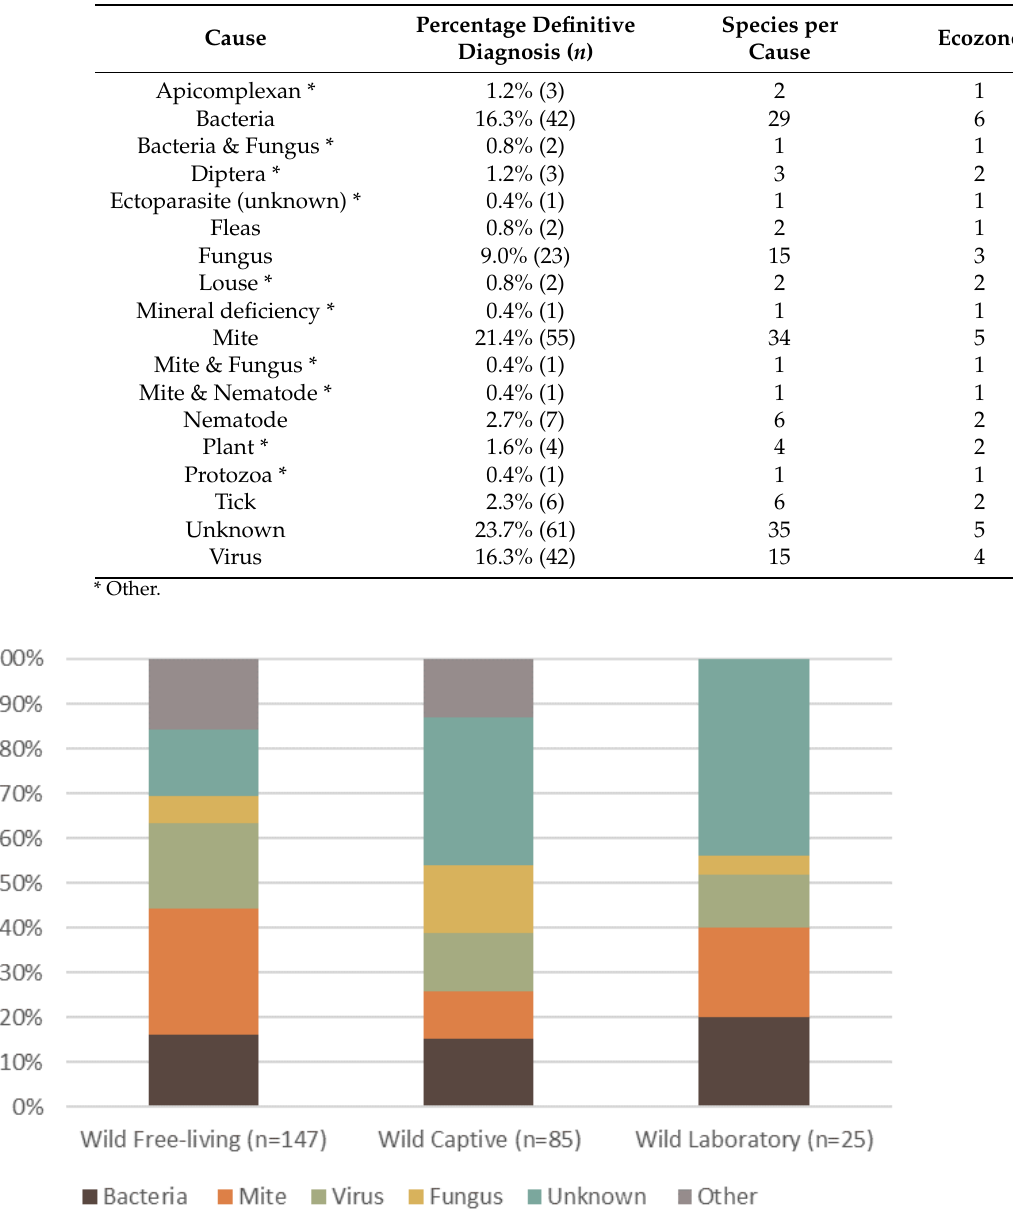
Figure 2. Proportion of the top five causes of dermatitis reported in terrestrial mammalian wildlife, summarized into each captive or free-ranging group. Captivity status consists of wild free-living, wild-captive and wild-laboratory. The percentage of definitive dermatitis causes reported in wildlife is shown for each group.